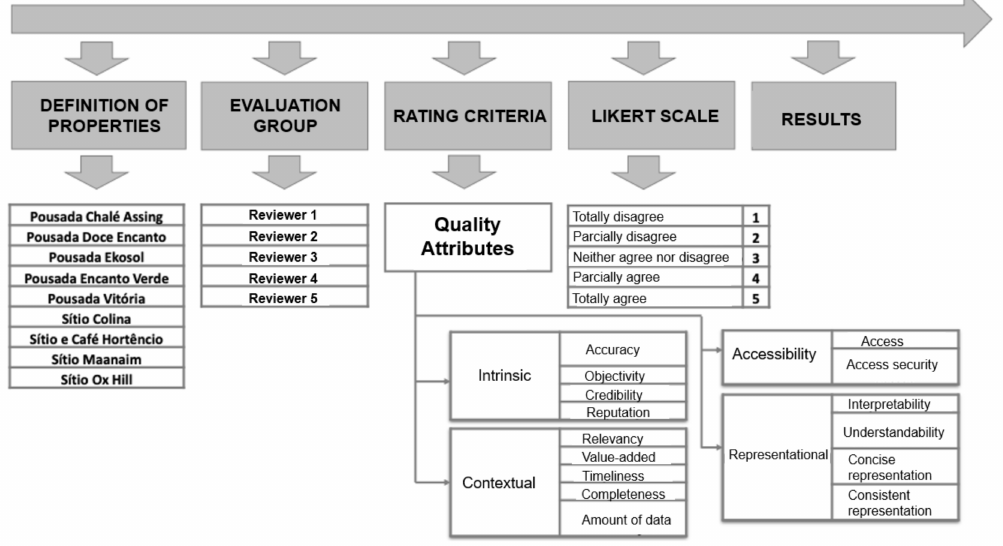
Figure 1. Process of analysis and evaluation of